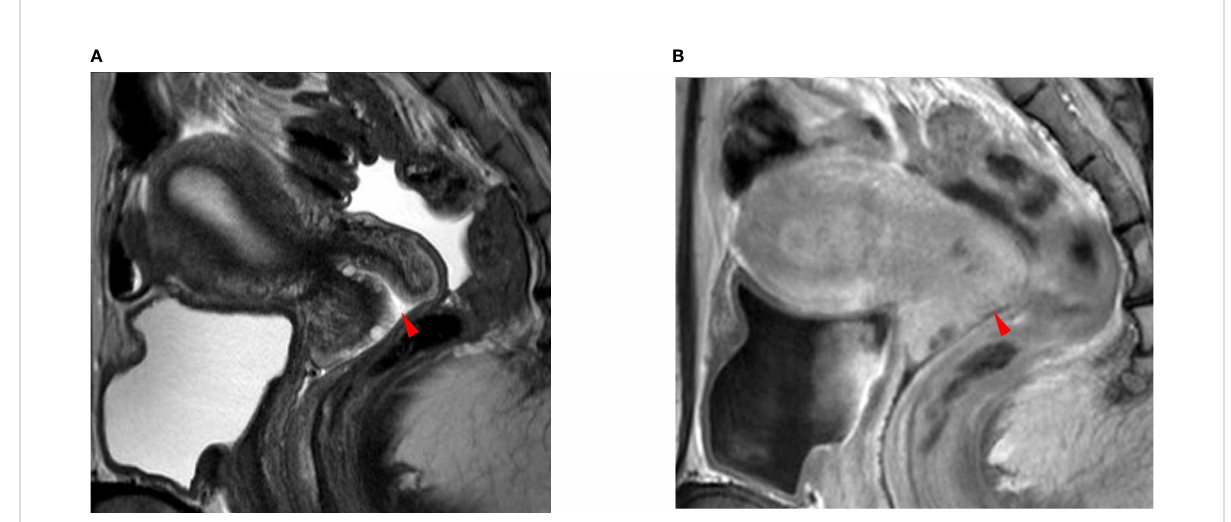
FIGURE 1 A 35-year-old woman with squamous cell carcinoma. (A) The T2-weighted sagittal MR image shows no focal lesion in the cervix. The red arrowhead indicates the external OS of the uterine cervix. (B) The delayed contrast-enhanced sagittal MR image shows no residual cancer in the cervix. The red arrowhead indicates the external OS of the uterine cervix. The pathologic report con fi rmed no residual cancer in the resected uterus. There was also no invasion of the lymphovascular space, vagina, parametrium, or lymph node